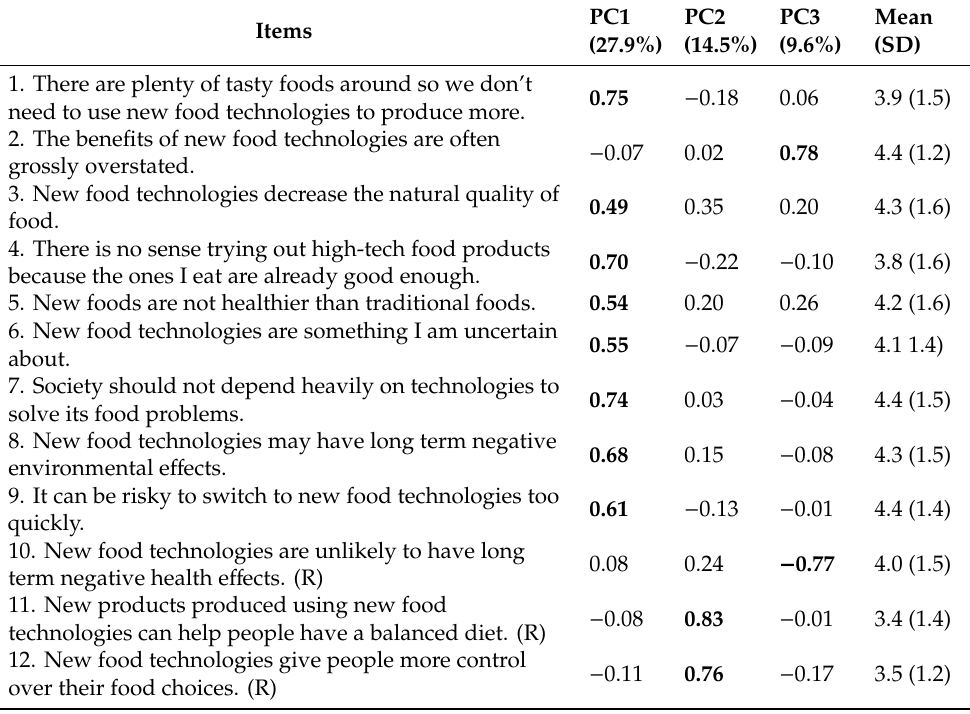
Table 2. Food Technology Neophobia Scale: Explained variance (%), factor loadings, items mean and standard deviation. R = reversed